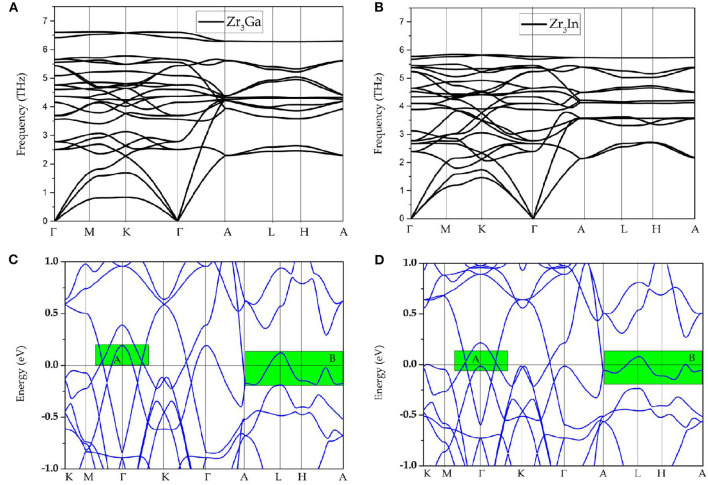
(A,B) Phonon dispersions of Zr3Ga and Zr3In, respectively; (C,D) calculated band structures of Zr3Ga and Zr3In, respectively; here, band-crossings around the Fermi level are highlighted by green rectangles.